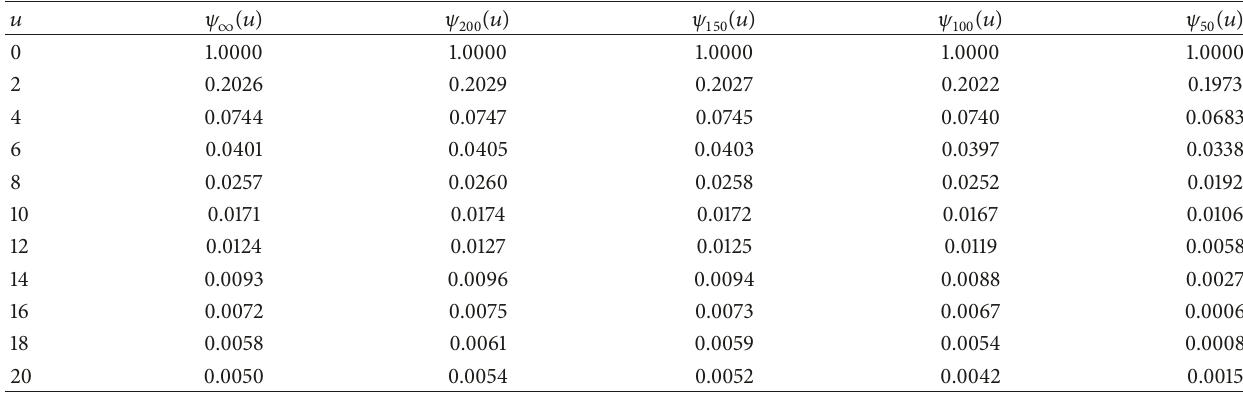
Table 4: Ruin probabilities for XL reins. in DPM: Par (3,2) claims ( 𝜆 = 2, 𝑐 = 6,𝜎 = 0.02 ).